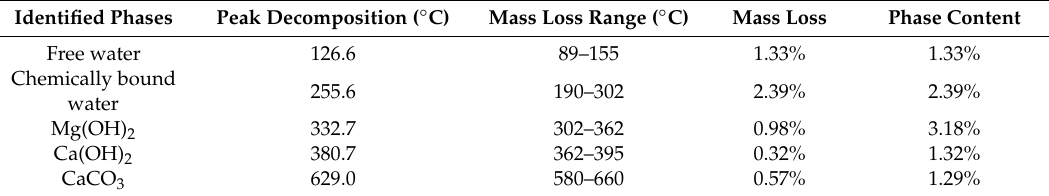
Table 5. Phase identification and content by TGA.